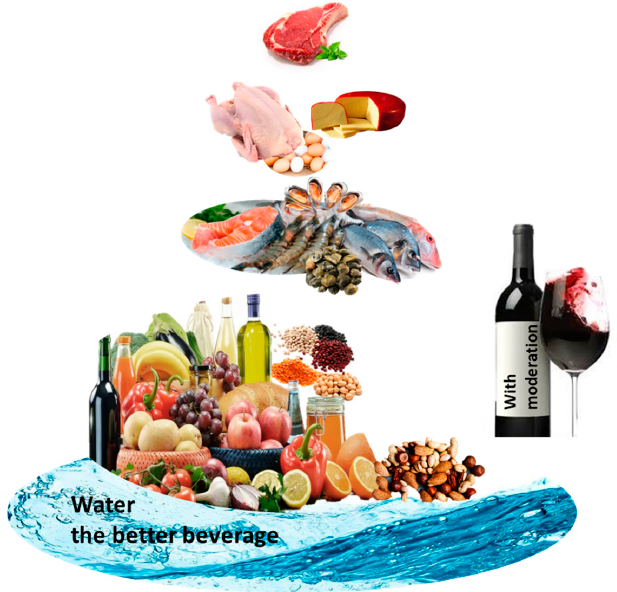
Figure 5. The Mediterranean diet pyramid.